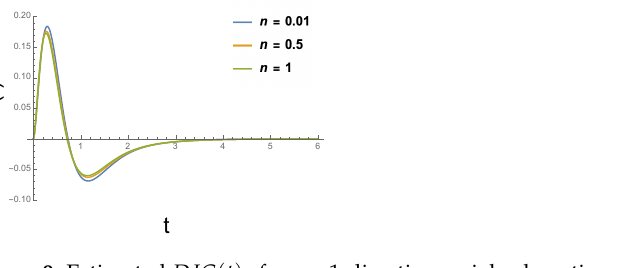
Figure 9. Estimated DIC ( t ) s from a 1-direction serial exhaustive system having Gumbel’s bivariate exponential distribution where q ( A , B ) = B . A L = 3, A H = 12, B L = 1, B H = A n